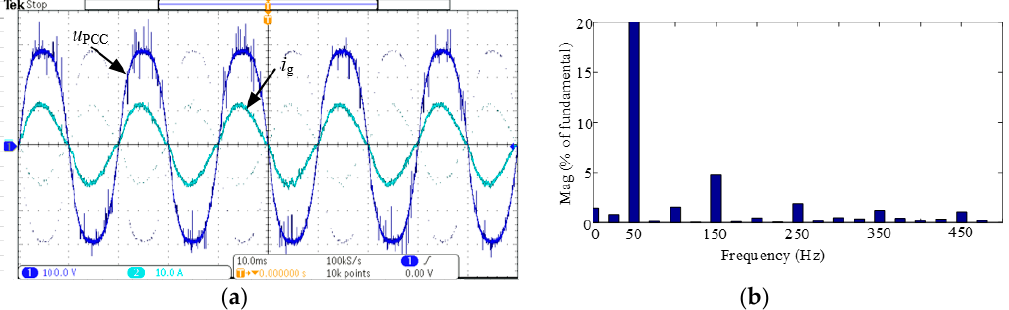
Figure 20. The experimental results of the FF (Feed Forward) strategy. ( a ) Waveforms of grid voltage and current, and ( b ) the FFT analysis of grid current (THD = 5.78%).